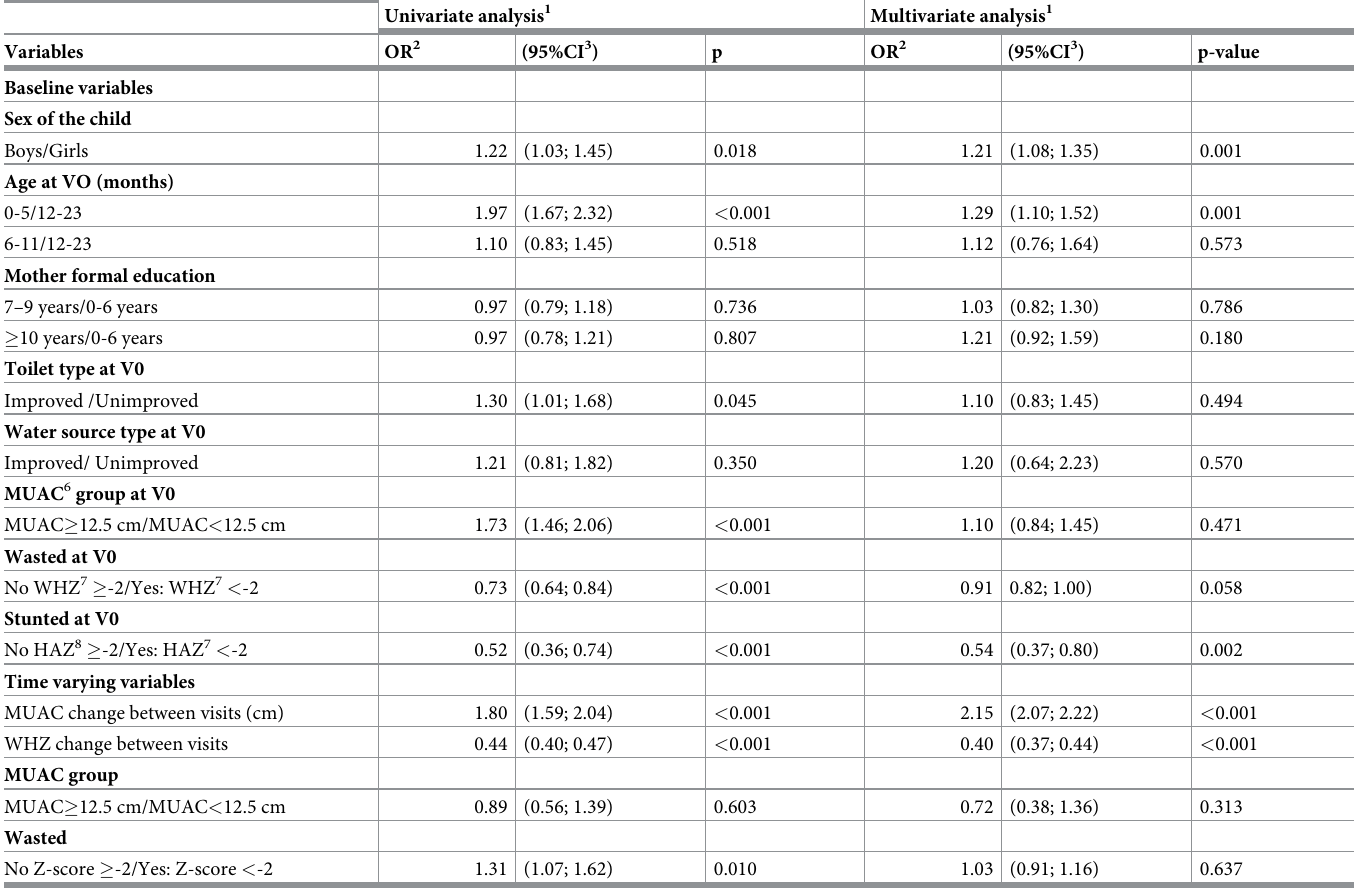
Table 4. Association between stunting, wasting parameters and occurrence of accelerated linear growth in the 4630 children included in the analysis (n = 14340 & n episodes =